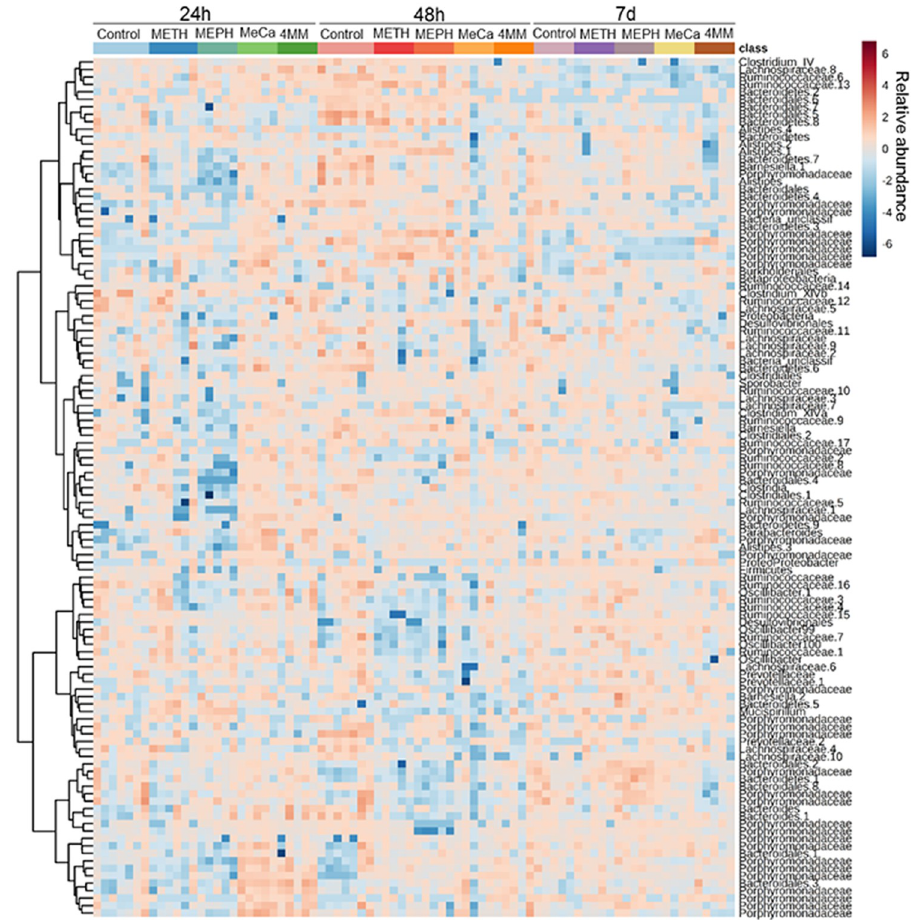
Fig 3. Heat map illustrating the relative abundances of OTUs after treatment with study drugs. The most prominent OTUs ( � 1% average relative abundance) among treatment groups are plotted for each drug at 1, 2 h or 7 days after drug injections. Clustering was done using the Ward